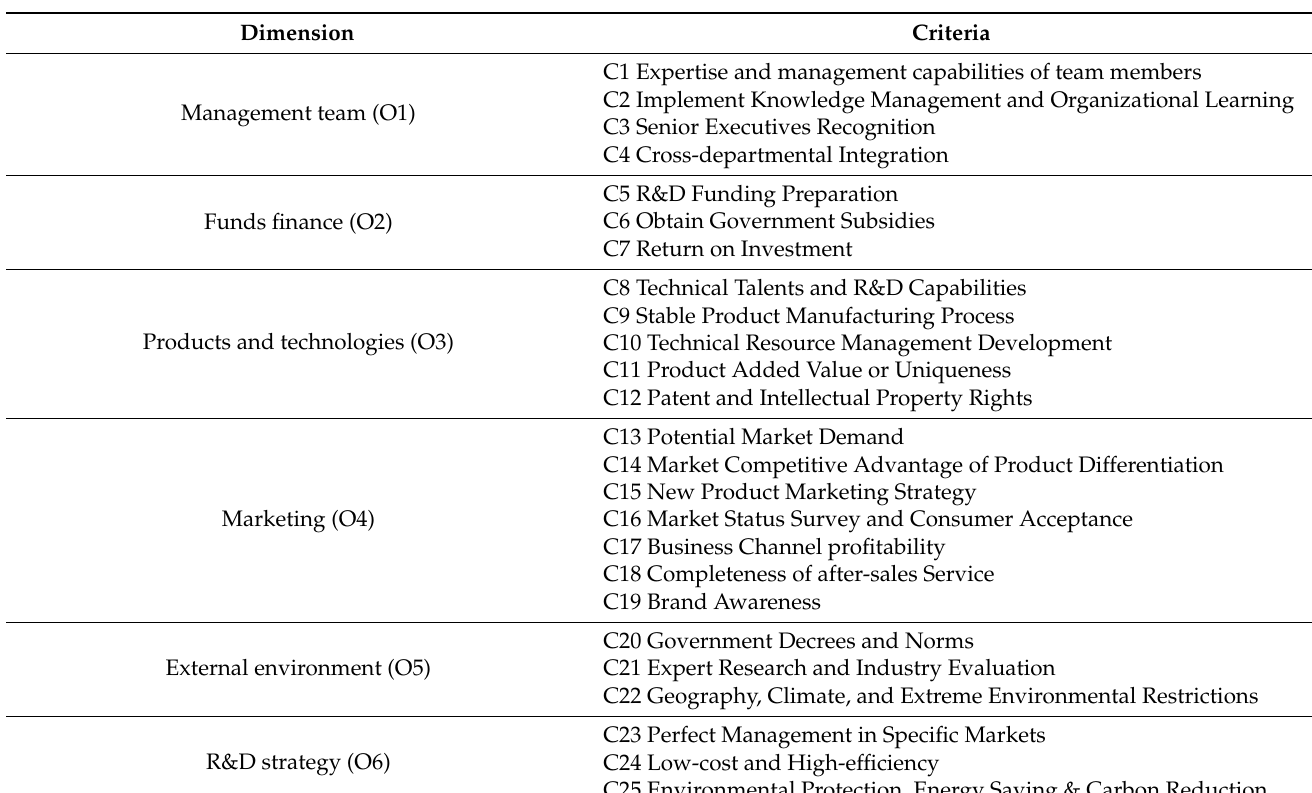
Table 6. Crucial criteria of MCDM model of OLED